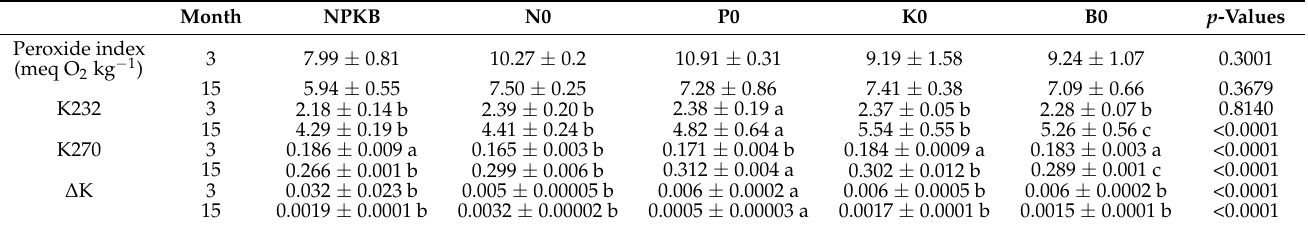
Table 7. Quality indices of olive oil (samples from the harvest of 2018 after 15 months of